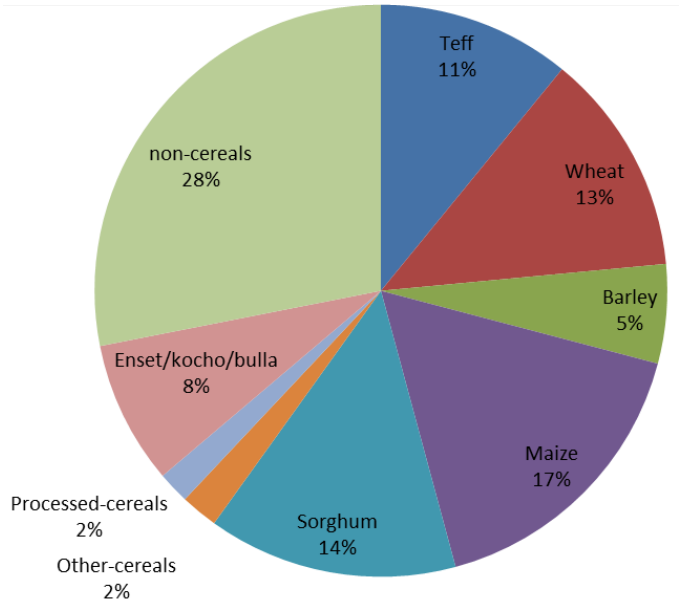
Figure 4.1 — Contribution to energy intake (calories) per capita of different cereals in